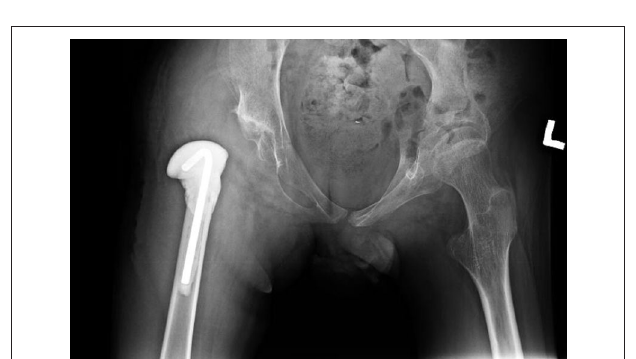
FIGURE 2 | Patient after PFIA – right side.